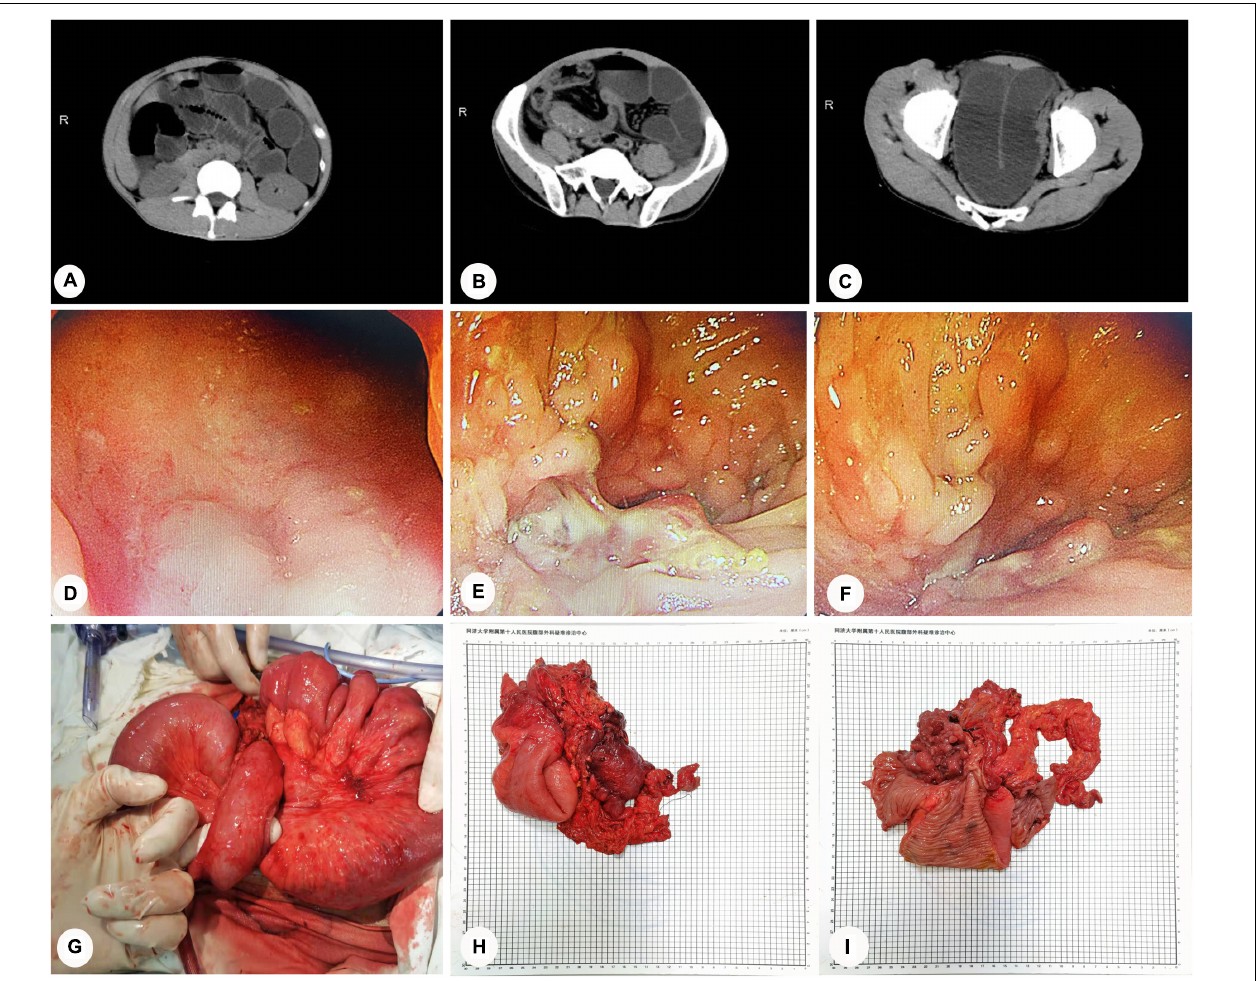
FIGURE 2 | Intestinal obstruction caused by CD combined with internal hernia and ileal stenosis (Case 2). (A–C) CT scans of abdomen: intestinal tract lesions in the right middle and lower abdomen, causing a proximal small intestinal obstruction. (D–F) Endoscopic examination: noticeable mucosal swelling, irregular fissure ulcers, and multiple polypoid hyperplasias in the sigmoid colon (18 cm away from the anus). The intestinal cavity was so narrowed that the endoscope could not pass through it. (G) Intraoperative exploration: the proximal small intestine passed through the transverse mesocolon, causing the formation of the internal hernia. (H–I) The specimen of